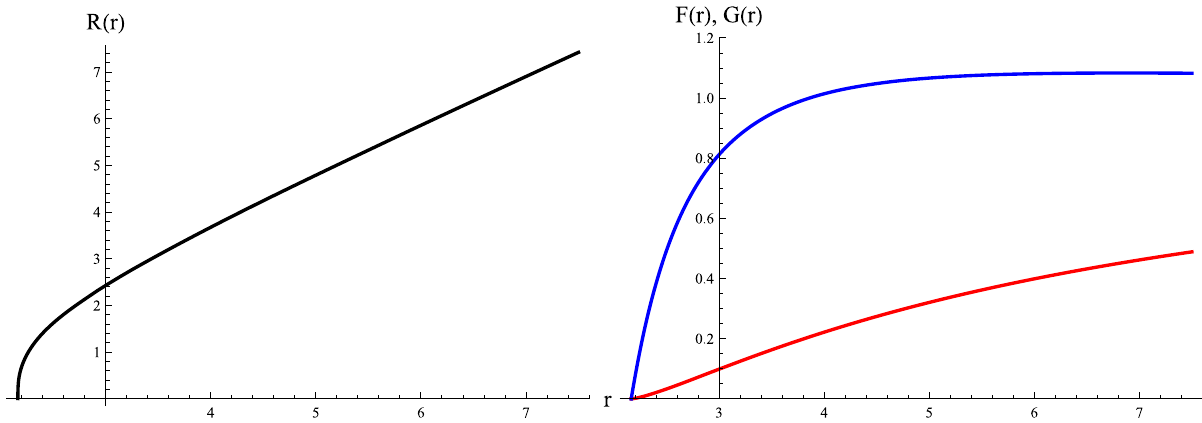
Fig. 4 Typical behaviors of R (left), F (right, red), and G (right, blue), where we have chosen a = 3, b = 2, and h = 0. At R = 0, F and G both approach to zero and hence the surface is null